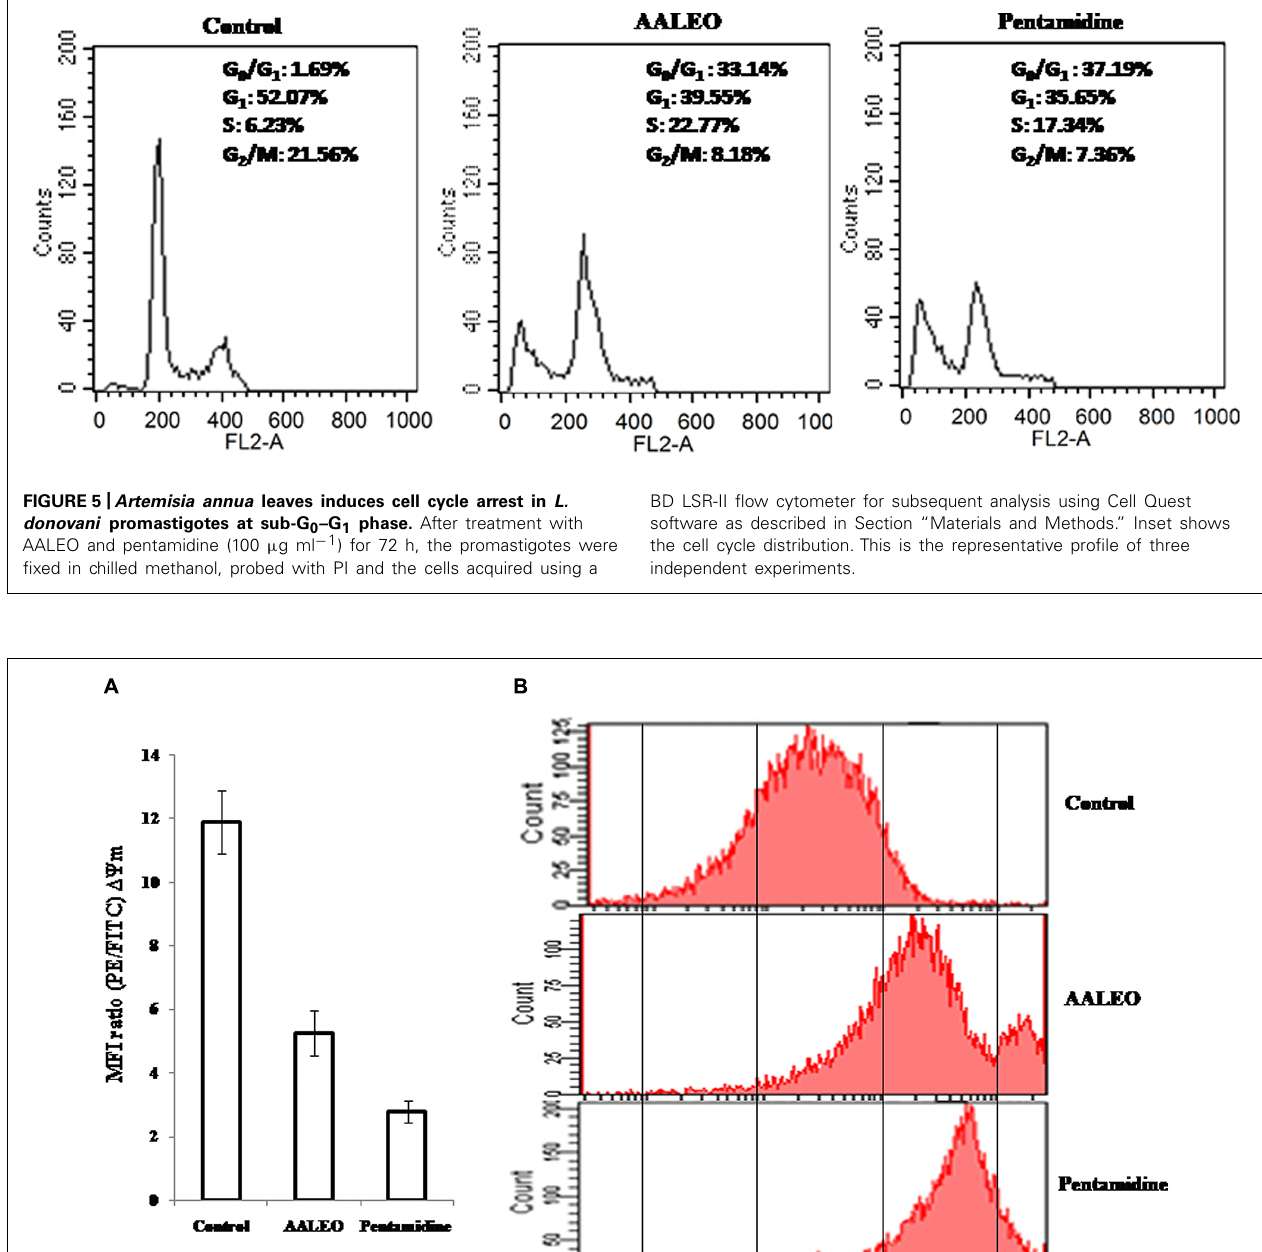
FIGURE 6 | Collapse of mitochondrial membrane potential and ROS generation in L. donovani promastigotes by AALEO. Exponential phase promastigotes were incubated with AALEO and pentamidine (100 μ g ml − 1 ) for 72 h and (A) probed with JC-1; bar diagram represents the ratio of red/green fluorescence intensity (MFI) obtained from histogram